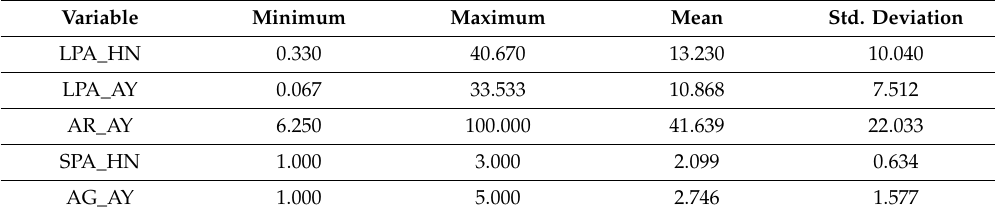
Table 1. Summary statistics of aphid population and trichomes count at two locations.